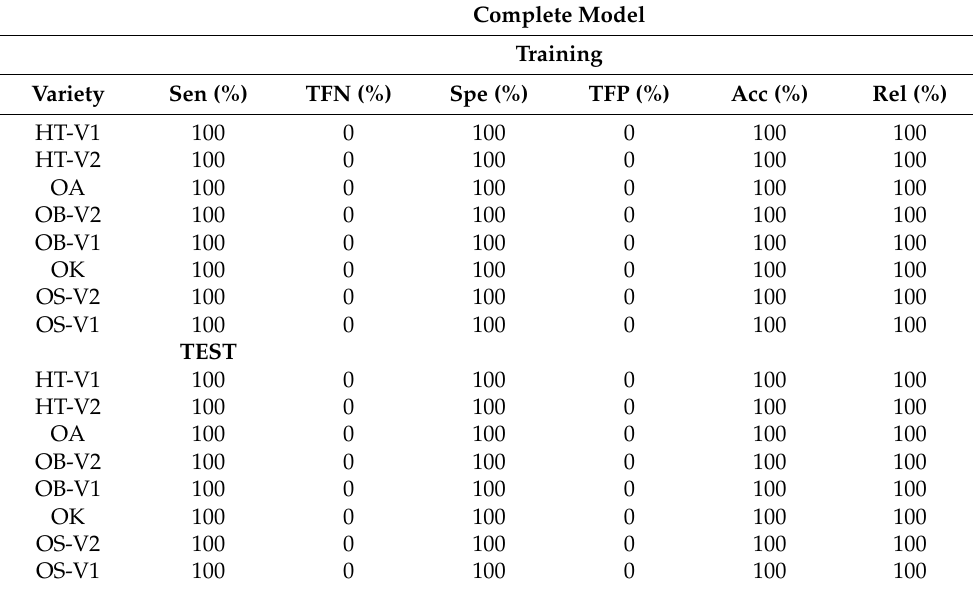
Table 1. Calculated values for the merit figures for the PLS-DA model using FT-NIR data for Ocimum species and varieties.